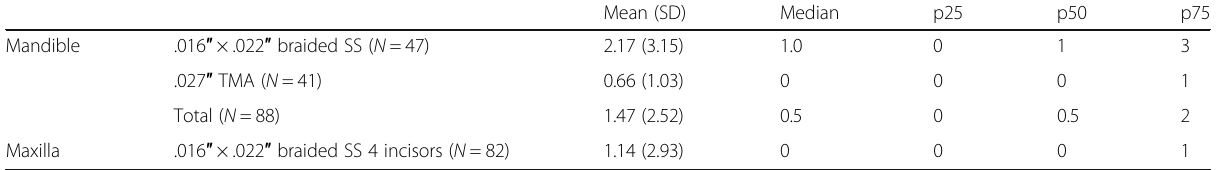
Table 8 Failures per patient in the mandible and maxilla according to the type of retainer